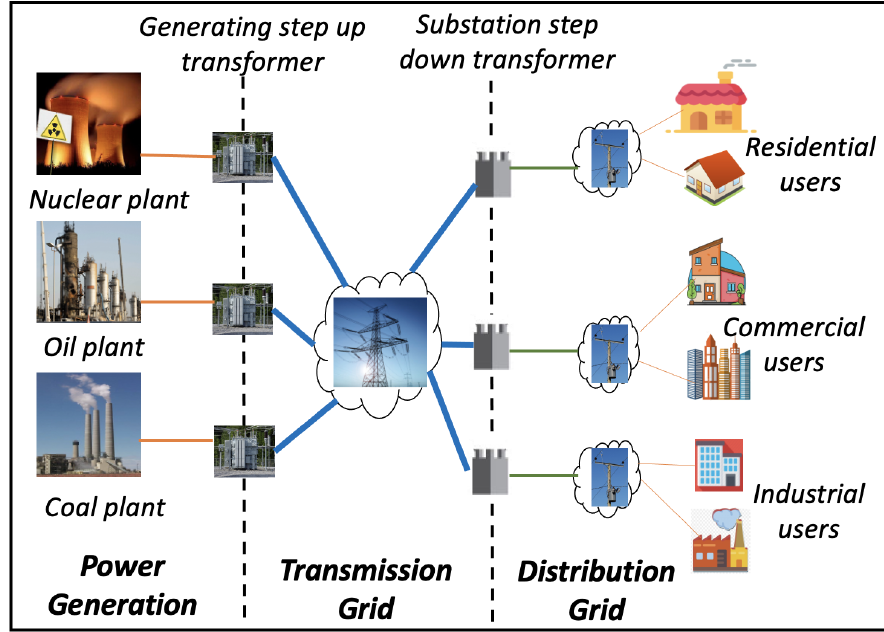
Figure 3. Traditional